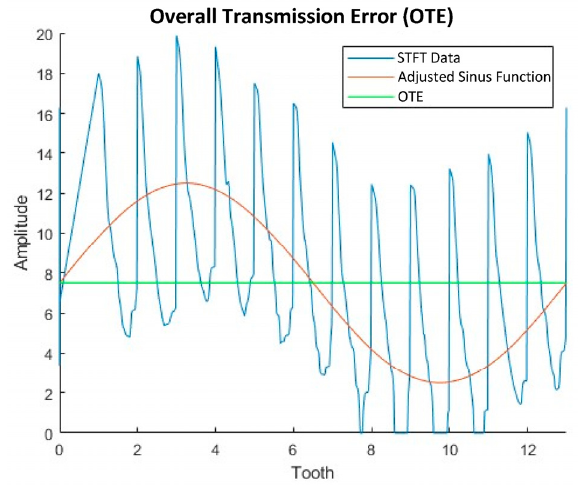
Figure 7. Visualization of the overall transmission error (OTE).